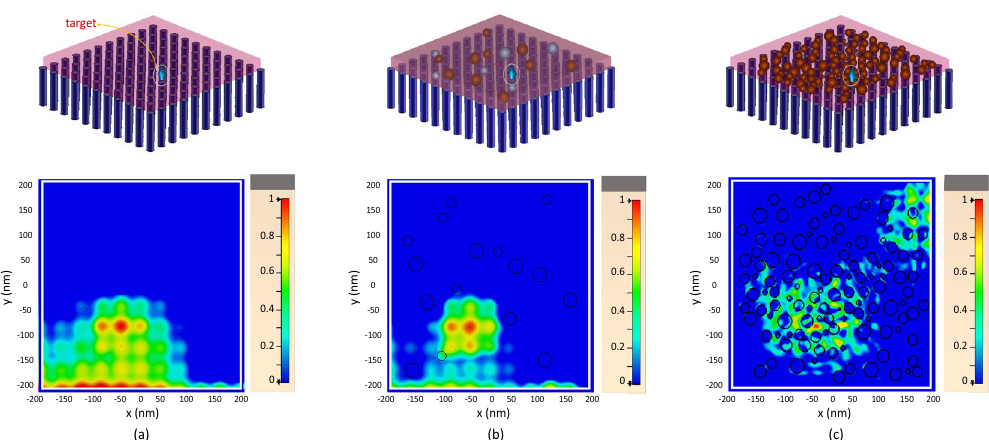
Figure 3. Super-resolution property of the structure in the focusing scheme inside tissue samples with different scatterer densities of ( a ) zero (homogeneous medium), ( b ) 2% and ( c ) 20%. Tissue sample on top of the nanorod lens (top) and normalized field distribution inside tissue (bottom).